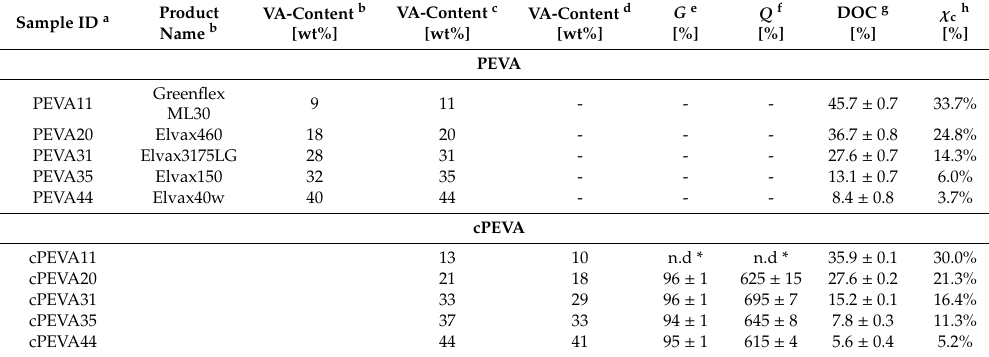
Table 1. Composition and crystallinity of PEVA and covalently crosslinked PEVA (cPEVA). Sample ID